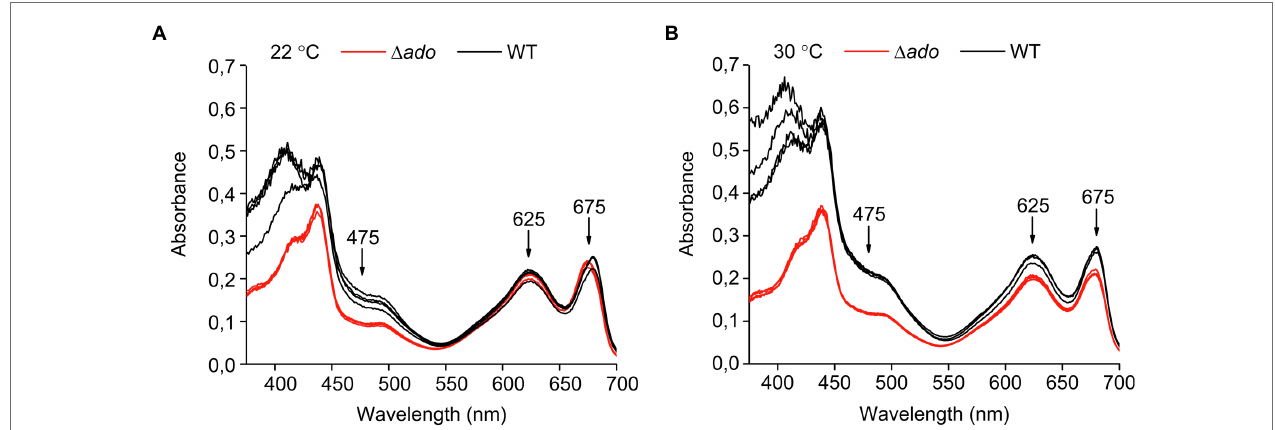
Glycogen was broken down and quantified as glucose, and the averages and standard deviations for both compounds were calculated based on three biological replicates. Asterisks indicate statistically significant (p < 0.05) differences in the measured parameters in the Δ ado mutant strain in comparison to WT under 22 ° C and 30 ° C, as analyzed using two-sided two-sample t test.